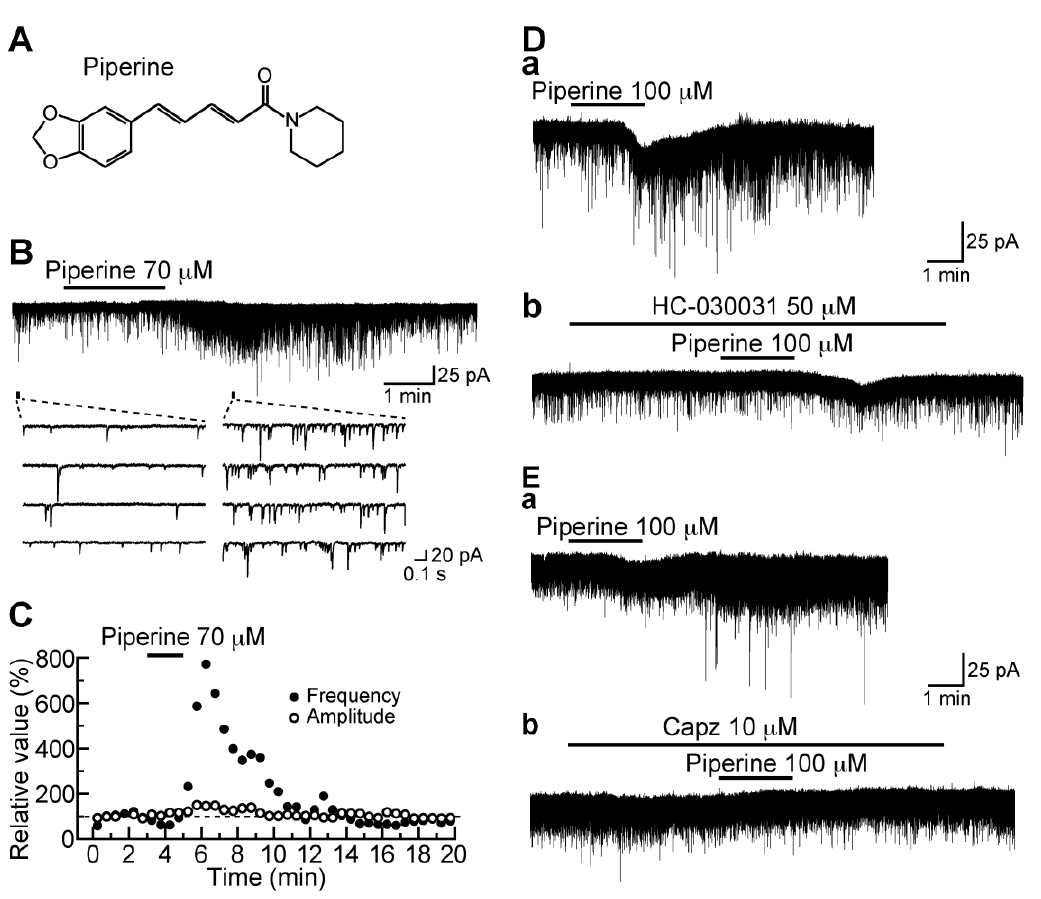
Figure 7. Effect of piperine on spontaneous excitatory transmission in rat SG neurons. ( A ) The chemical structure of piperine; ( B ) Recordings of sEPSCs in the absence and presence of piperine (70 µM); ( C ) sEPSC frequency and amplitude (closed and open circles, respectively) under the action of piperine, relative to those before its superfusion (frequency and amplitude: 3.6 Hz and 13.4 pA, respectively). They were measured every 0.5 min; ( B ) and ( C ) were obtained from the same neuron; ( D , E ) Chart recordings showing the action of piperine (100  µM) on excitatory transmission in the absence ( a ) and presence ( b ) of a TRPA1 antagonist HC-030031 (50 µM; D ) or Capz (10 µM; E ). V = −70 mV. Modified from [58] with permission of Elsevier H